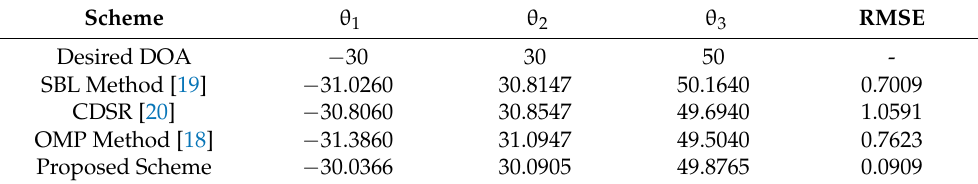
Table 7. DOA Estimation for Three Targets for N = 5 and M = 4 with SNR = 20 dB.